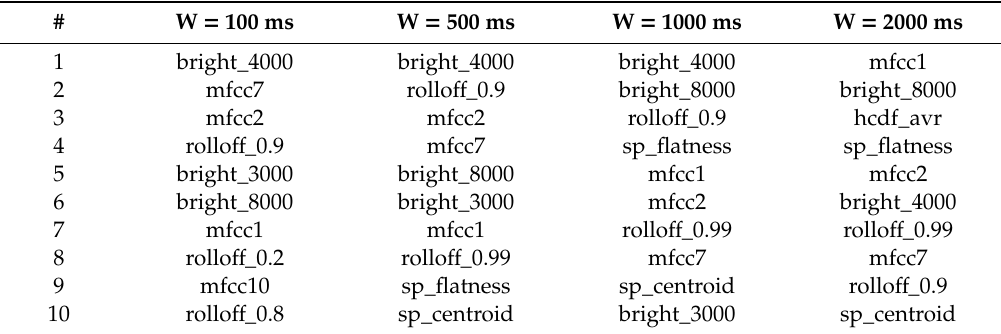
Table 3. Feature Ranking for the main speakers, telephone conversations and music interferences (VPM) Classification